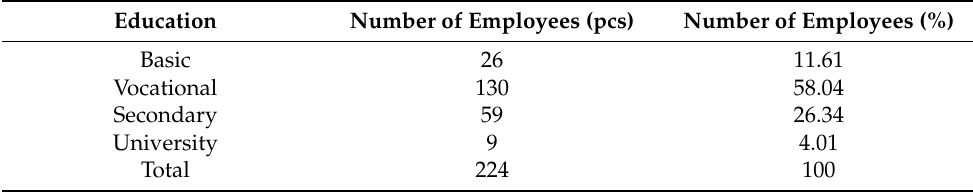
Table 1. Education of workers in the